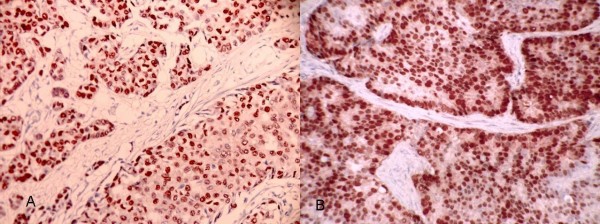
Examples of strong nuclear immunostaining with hormonal receptors. (a) ER+. (b) PR+.